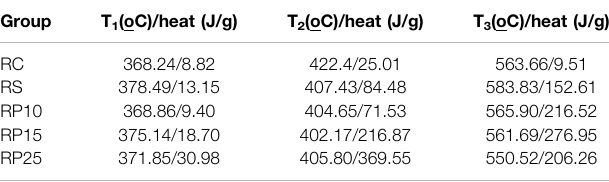
TABLE 7 | Thermal decomposition events of EABRP enriched composite